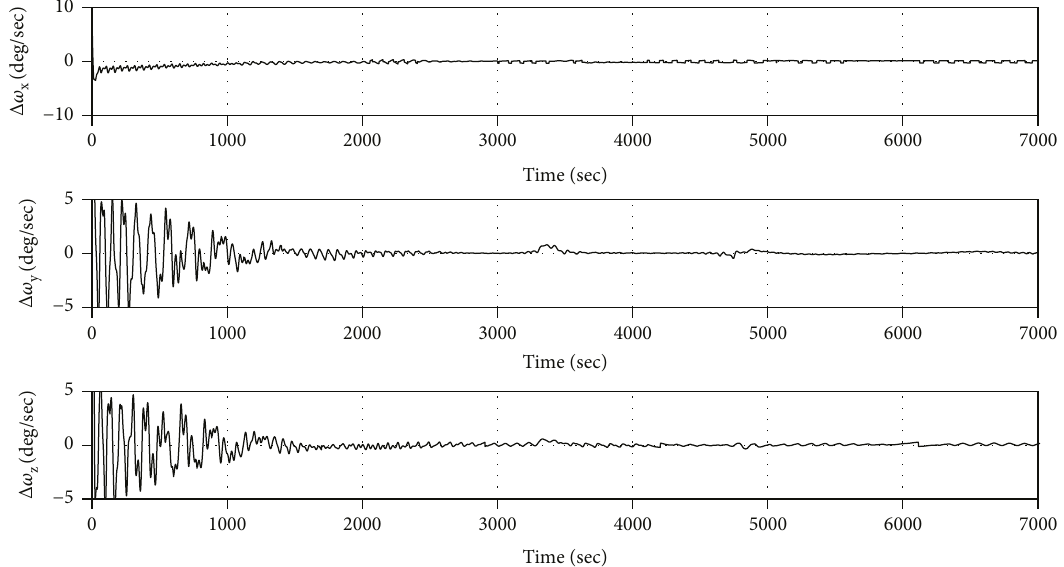
ω ω x , y , and z ) for a Y-Thompson spin control.